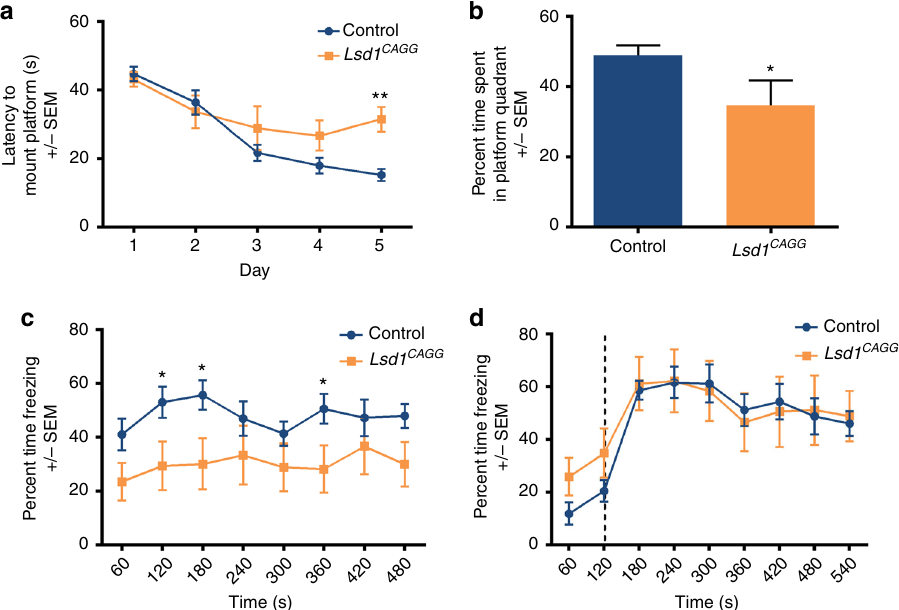
Fig. 2 Loss of LSD1 results in learning and memory de fi cits. a Latency to mount platform (in seconds) in the Morris water maze across the 5 day training period of control (blue, n = 15) and Lsd1 CAGG (orange, n = 12) mice. Data are shown as mean ± s.e.m. ** P < 0.01 on day 5 compared by repeated measures two-way ANOVA with post hoc Sidak ’ s multiple comparisons test. b Percent time spent swimming in platform quadrant during probe (day 6) after 5 days of water maze training for control (blue n = 15) and Lsd1 CAGG mice (orange, n = 11) mice. Data are shown as mean ± s.e.m. * P < 0.05 by unpaired t -test. c Percent time spent freezing during contextual fear response after fear conditioning of control (blue, n = 12) and Lsd1 CAGG (orange, n = 8) mice. Data are shown as mean ± s.e.m. * P < 0.05 by unpaired t -test at individual timepoints. P = 0.052 for difference between genotypes by repeated measures two-way ANOVA. d Percent time spent freezing during cued fear response after fear conditioning of control (blue, n = 12) and Lsd1 CAGG (orange, n = 8) mice. Data are shown as mean ± s.e.m. Dashed line represents sound of